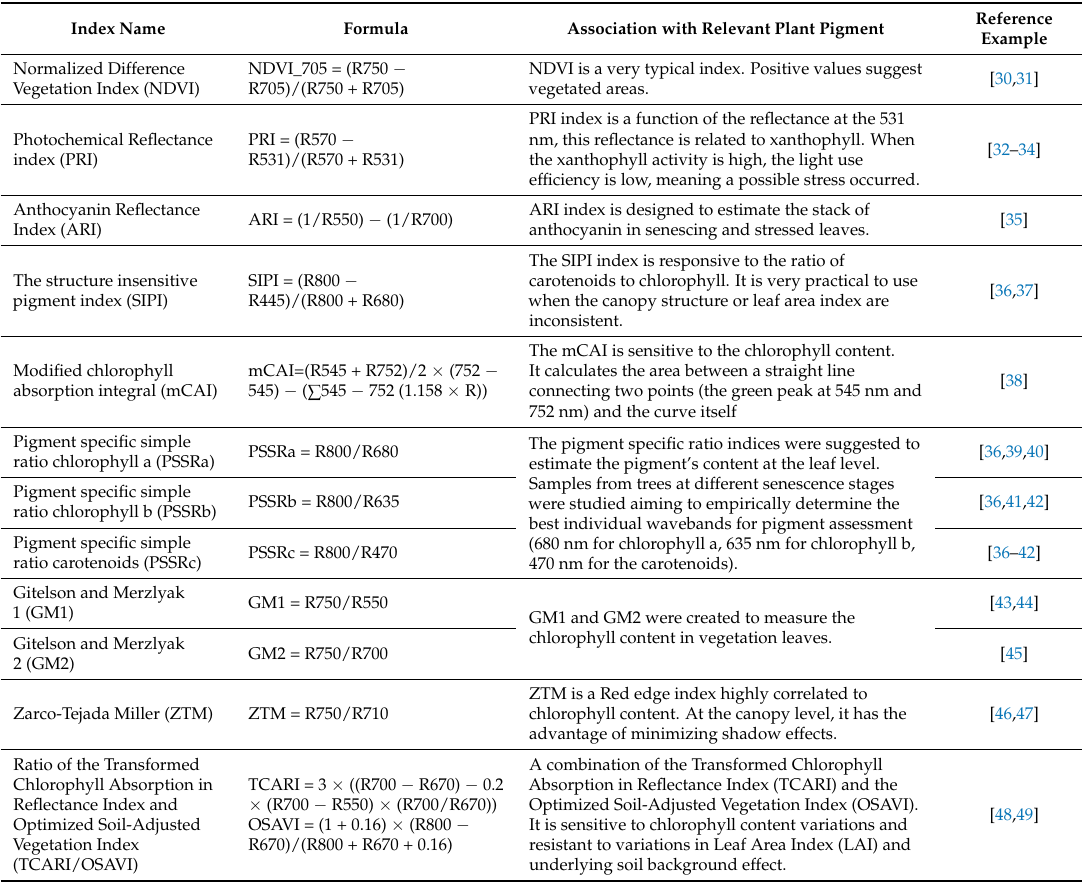
Table 2. Typical SVIs in literature and applied in this